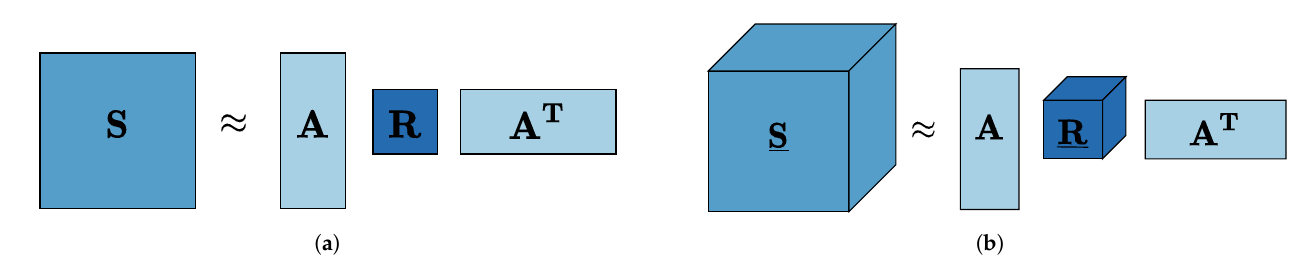
Figure 1. ( a ) The DEDICOM algorithm factorizes a square matrix S ∈ R n × n into a loading matrix A ∈ R n × k and an affinity matrix R ∈ R k × k . ( b ) The tensor DEDICOM algorithm factorizes a three dimensional tensor S ∈ R t × n × n into a loading matrix A ∈ R n × k and a three dimensional affinity tensor R ∈ R t × k × k